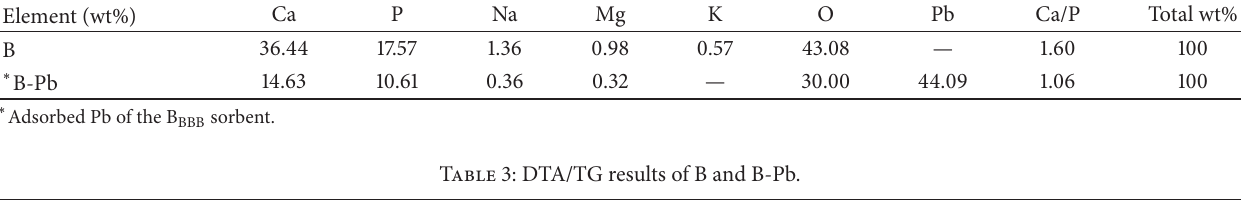
Table 3: DTA/TG results of B and B-Pb.